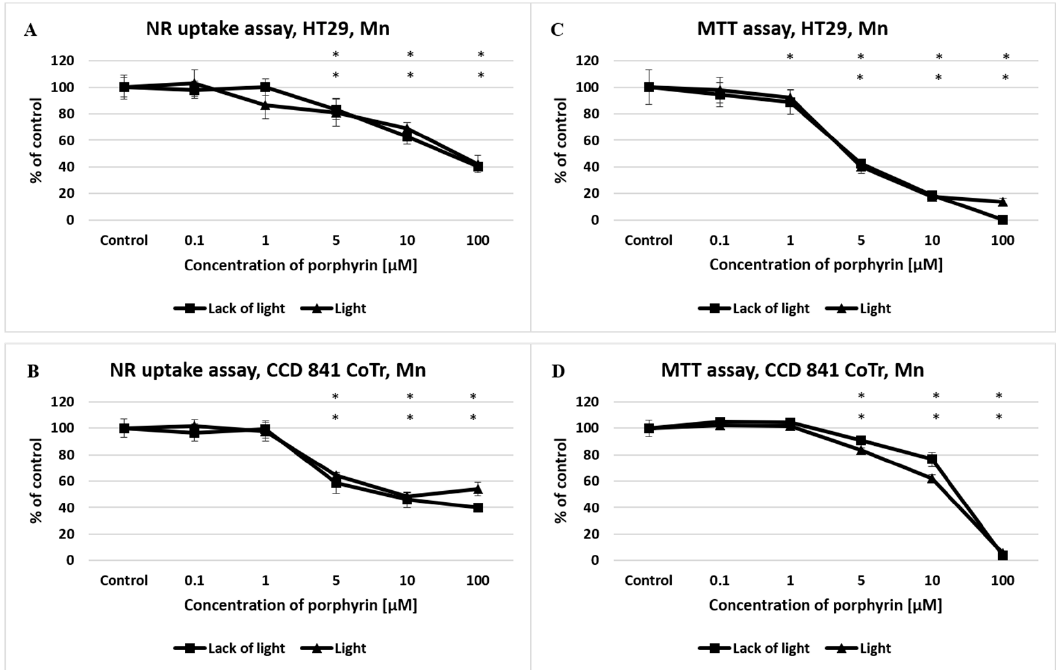
Figure 2. The effect of manganese porphyrin (Mn) on viability and mitochondrial metabolism of the HT29 cell line ( A , C ) and CCD 841 CoTr cells ( B , D ) after light induction and the absence of light. The neutral red (NR) uptake assay ( A , B ) and the MTT test ( C , D ). The results are presented as a percentage of the controls, arbitrarily set to 100%. The figures show averages of three independent experiments. *—Statistical significance was analyzed at p ≤ 0.05.